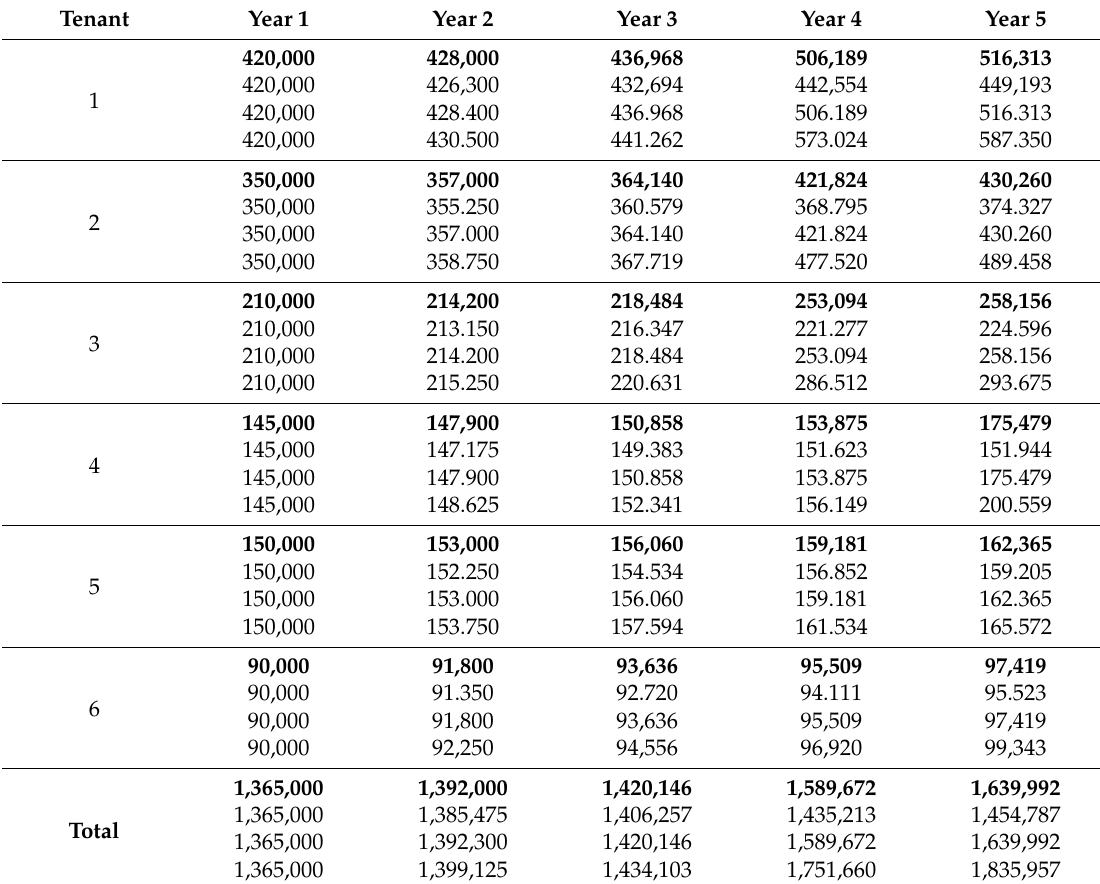
Table 3. Cash flow investment compared to the assumptions on growth rates of each